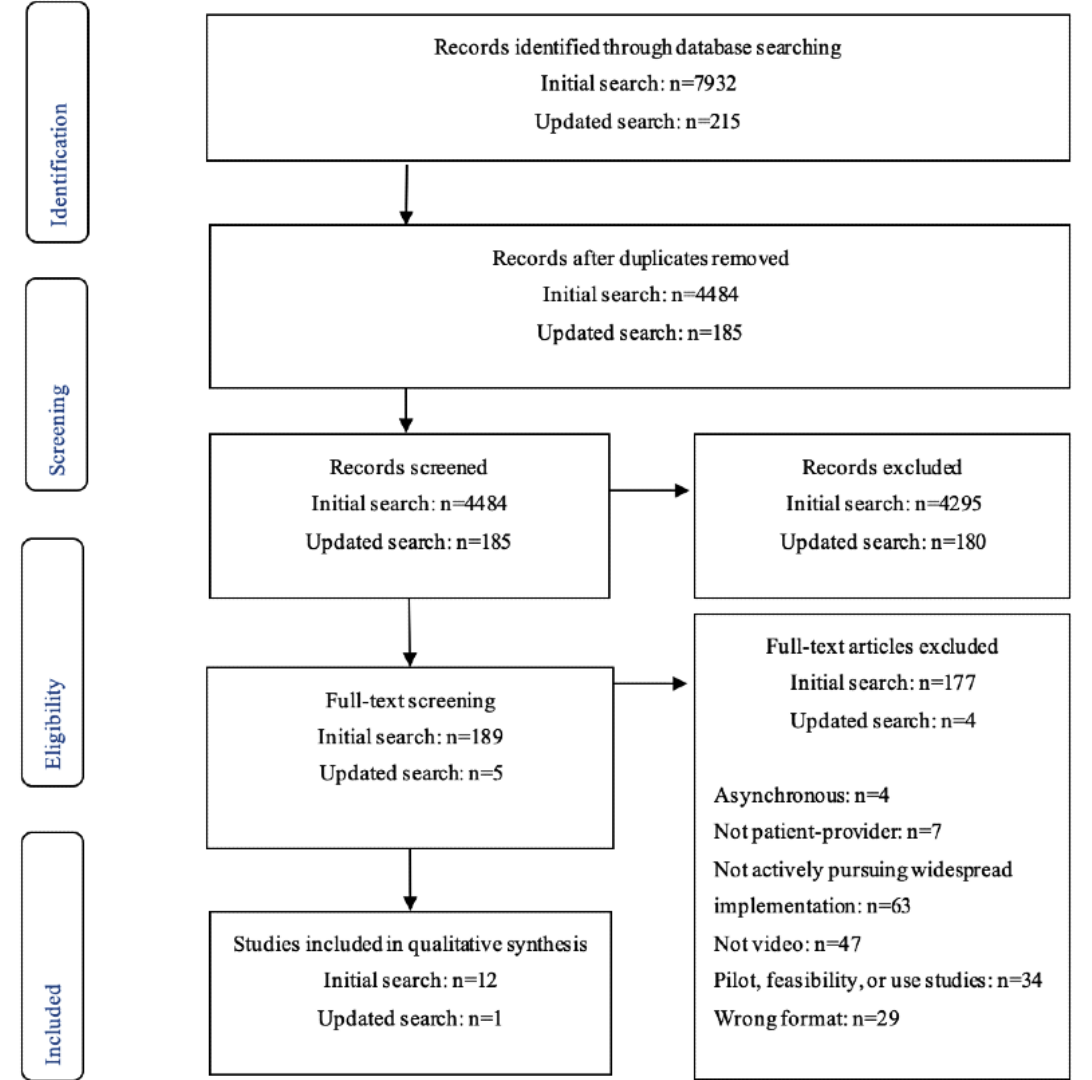
Figure 2. PRISMA flow diagram depicting search and screening processes. PRISMA: Preferred Reporting Items for Systematic Review and